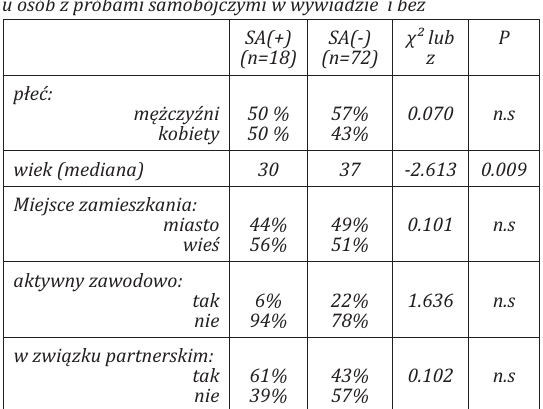
odpowiedzi: 1 – „zupełnie do mnie nie pasuje”, 2 – „trochę do mnie pasuje”, 3 – „trudno powiedzieć”,